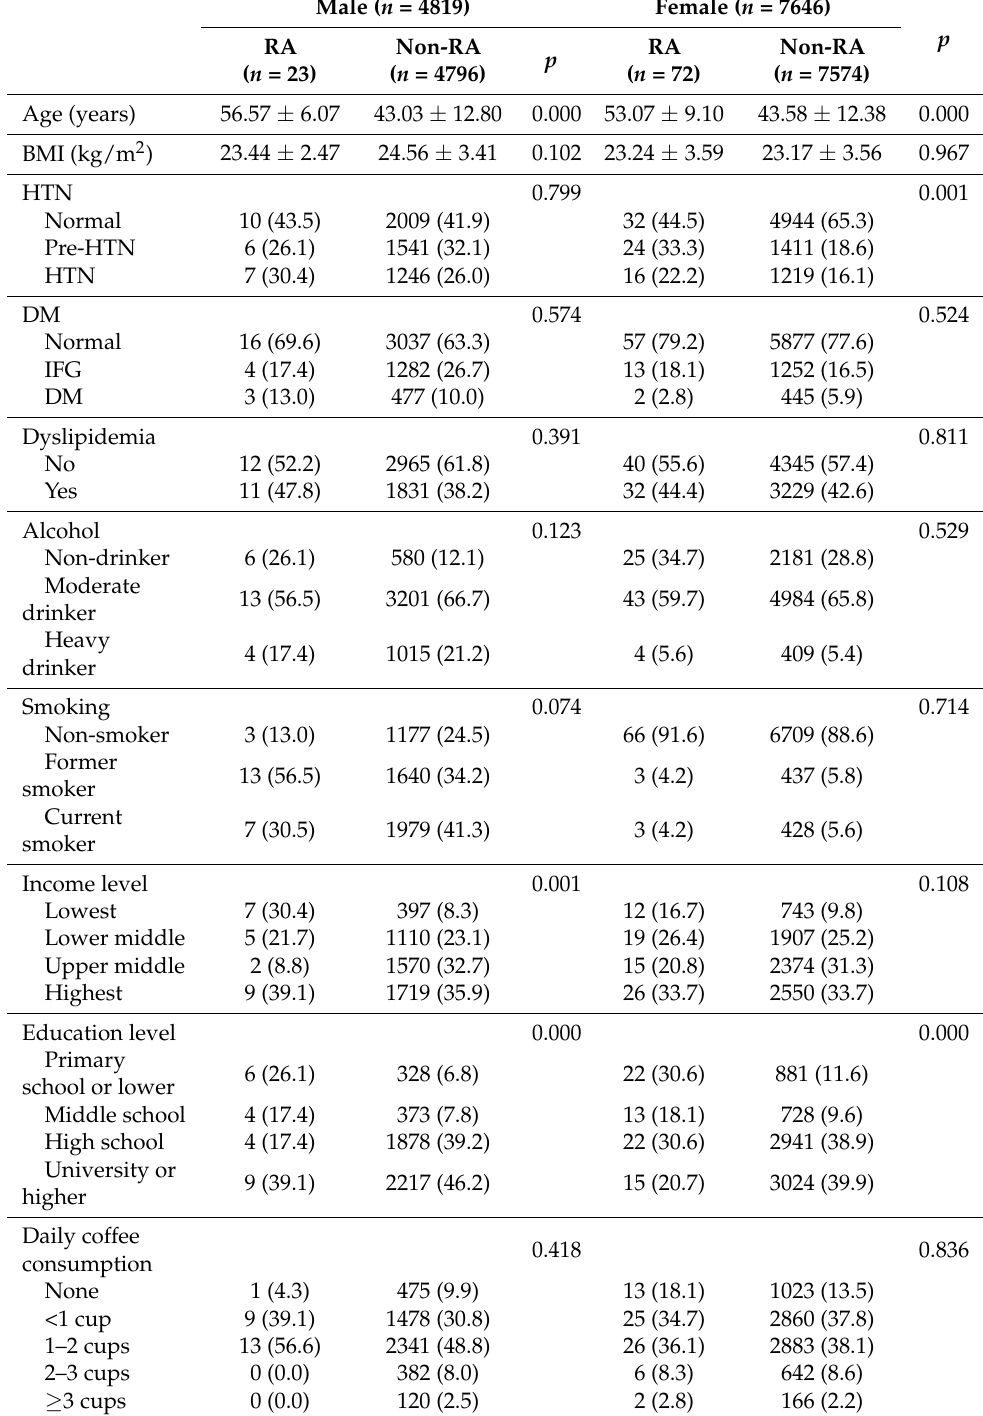
Table 1. Characteristics of participants with and without rheumatoid